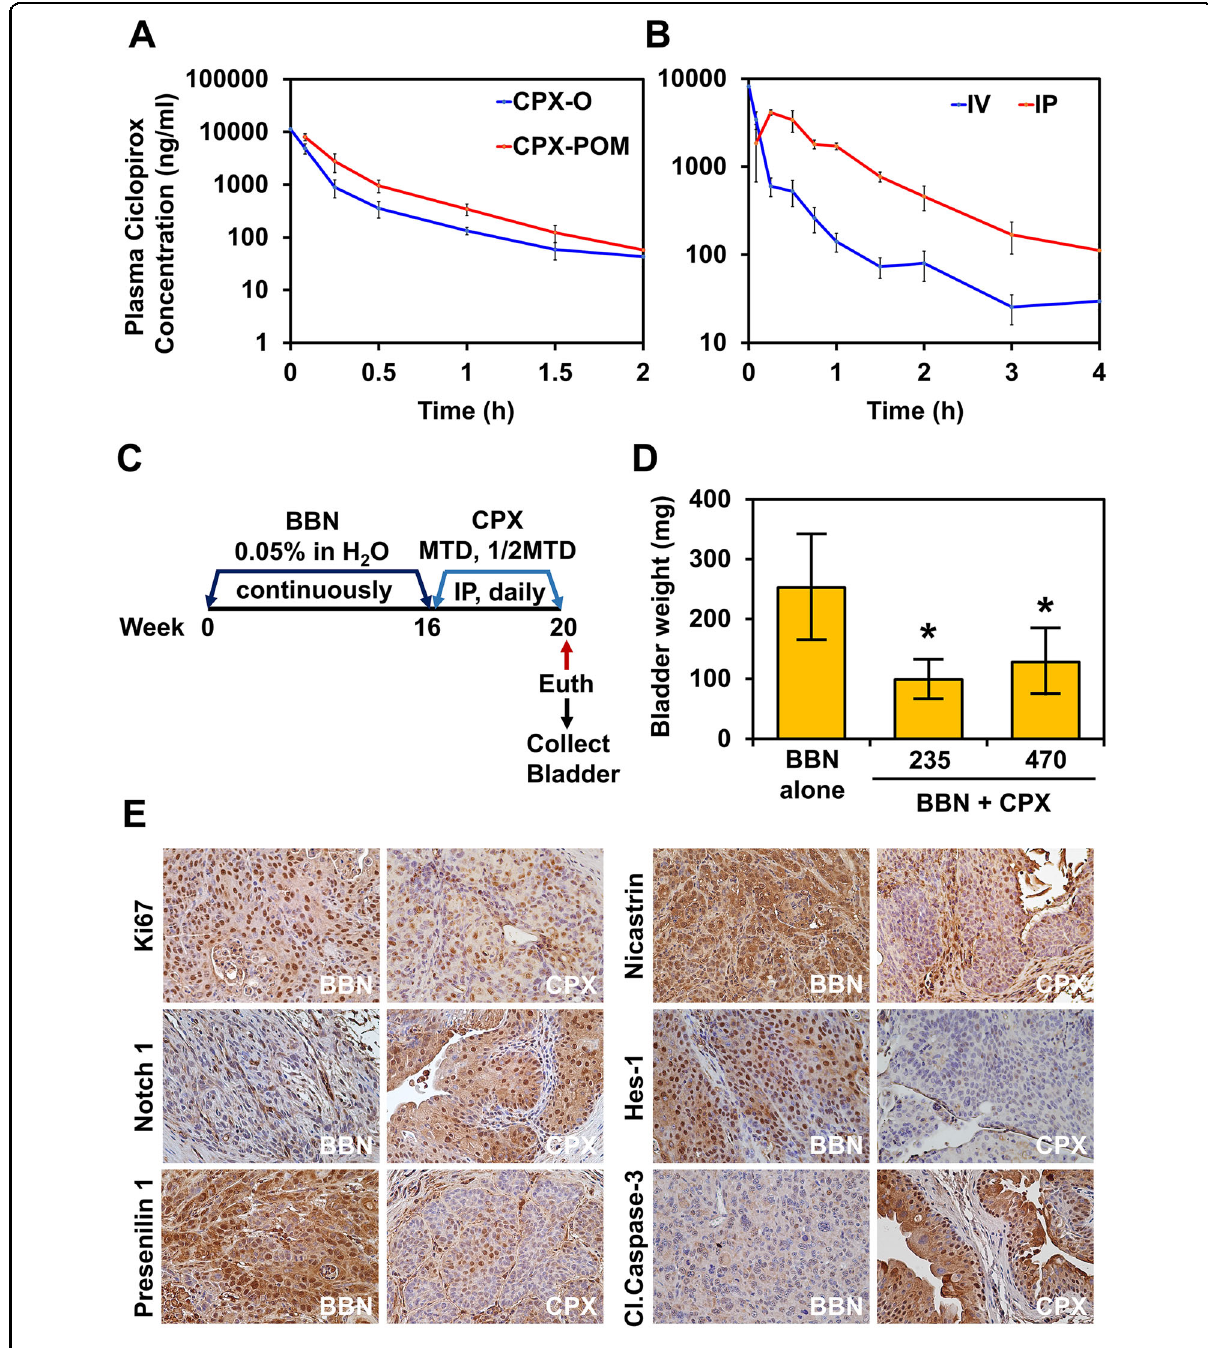
Fig. 6 (See legend on next